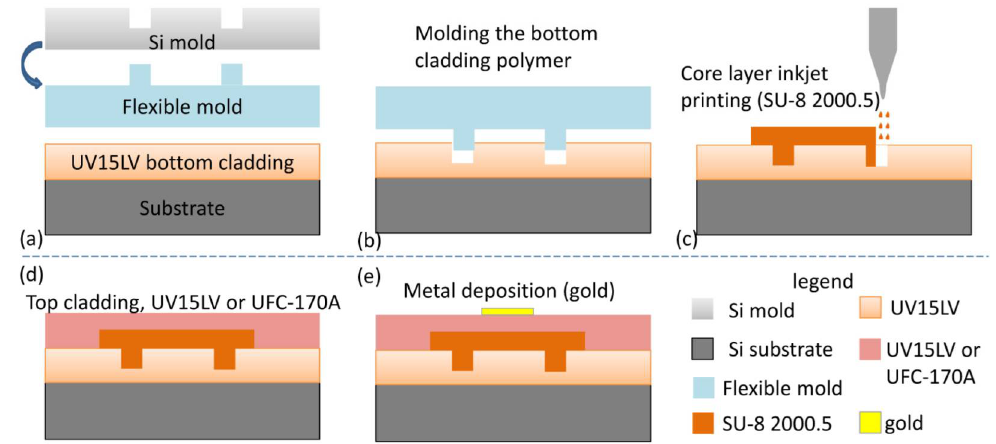
Figure 19. Process flow for fabricating a 2 × 2 thermo-optic polymer switch using imprinting and ink-jet printing method. ( a ) Silicon and flexible mold; ( b ) imprinting the bottom cladding; ( c ) core layer deposition; ( d ) top cladding deposition; and ( e ) metal electrode deposition [46]. Copyright 2013 OSA.